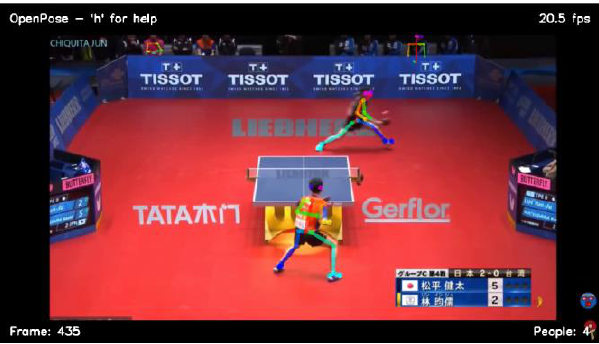
Figure 5. GPU version for real-time computation of the pose of a person in a video (up to 20.5 fps).